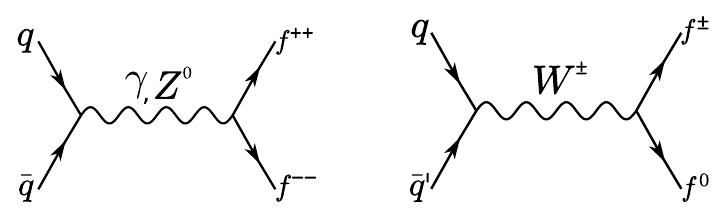
Figure 11 . Example Feynman diagrams for the production of exotic fermions appearing in our high- dimensional neutrino mass models. Here, f stands symbolically for a fermion from the multiplets